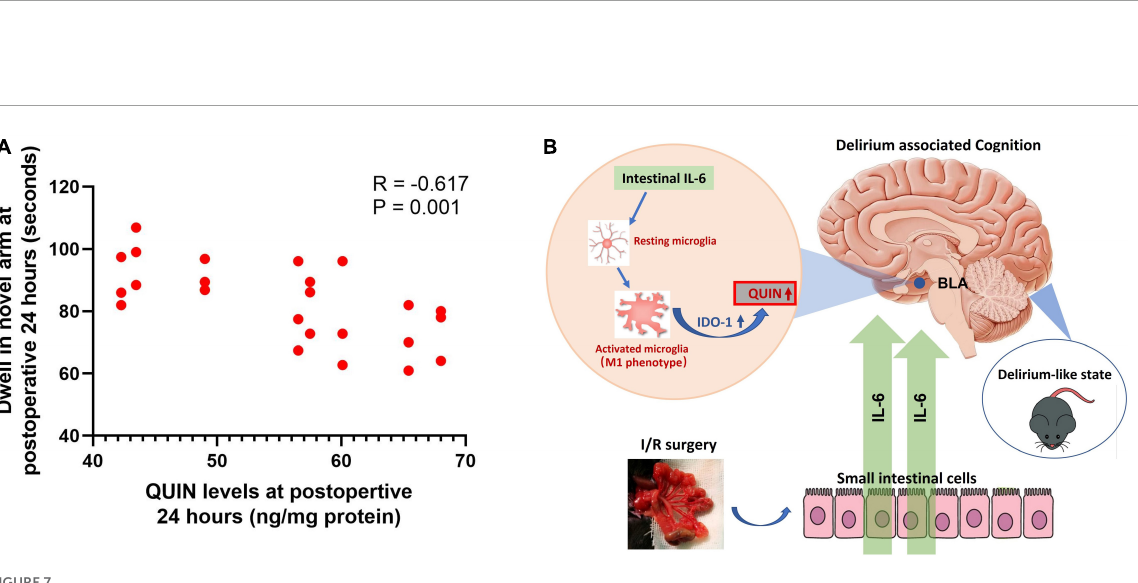
FIGURE7 Correlation analysis between QUIN and dwell time at Y maze and illustration of the pathway mediated the delirium-associated cognition in the model. (A) Correlation analysis in the I/R mice model, N = 24 per group. (B) Illustration of the